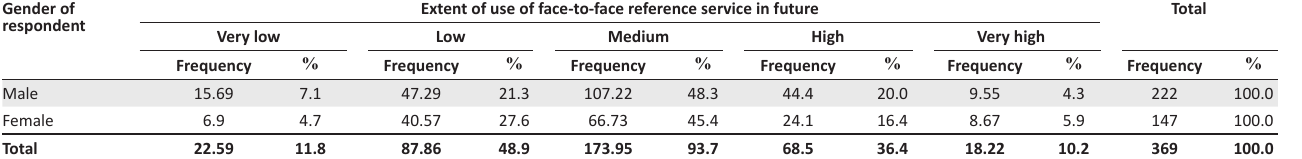
TABLE 8: Gender and effort by users of face-to-face reference service. Gender of